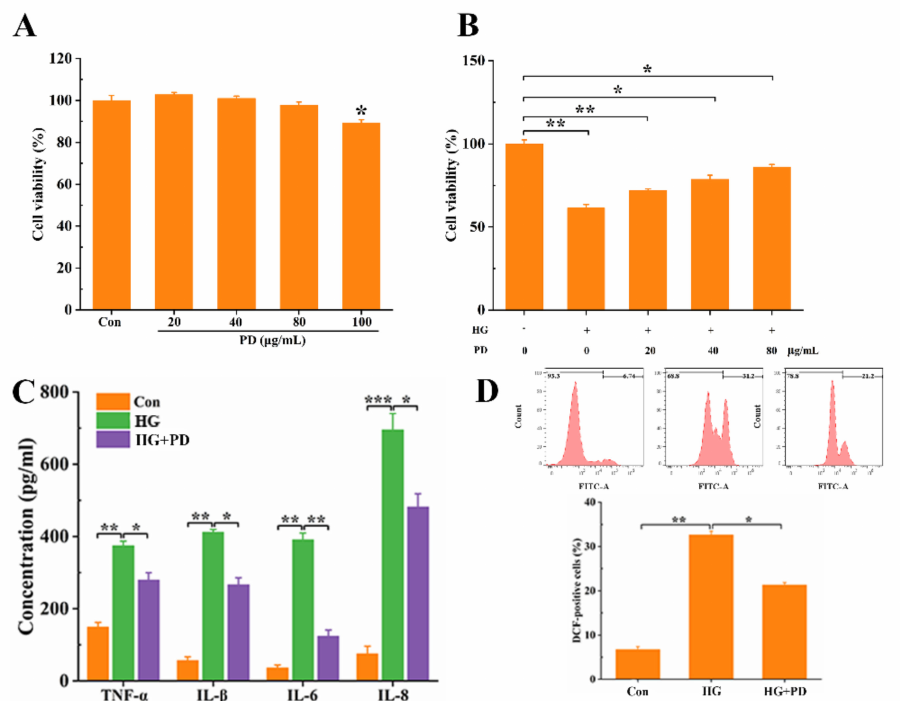
Figure 2. PD inhibits HG-induced oral mucosal cell inflammatory responses. ( A ) The oral mucosal cells were treated with different concentrations of PD (0, 20, 40, 80, and 100 ug/mL) for 48 h, and cell viability was examined by CCK-8 assay. After co-treatment with HG (50 mM) and PD (0, 20, 40, 80 ug/mL), cell viability ( B) , inflammatory response ( C ), and ROS ( D ) were detected. * p < 0.05, ** p < 0.01, *** p <